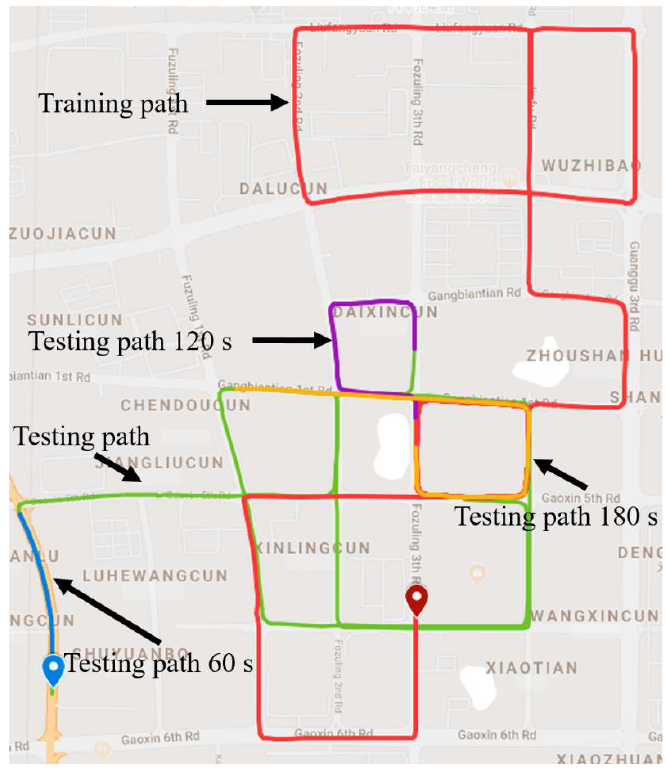
Figure 9. Trajectory for training path.